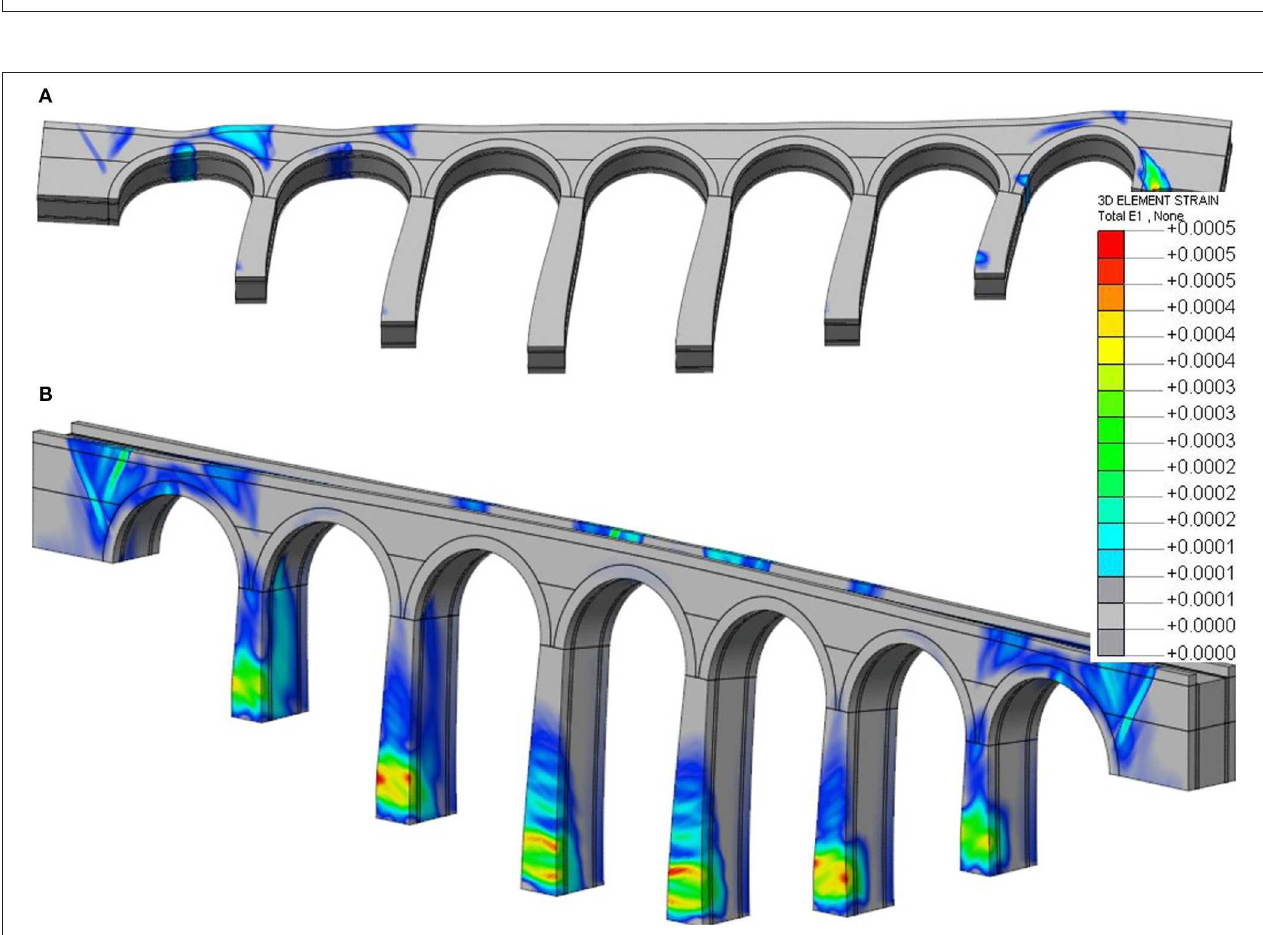
FIGURE 9 | Tensile principal Strain for the last step of the analysis. (A) Pushover curves in longitudinal direction. (B) Pushover curves in transverse direction.